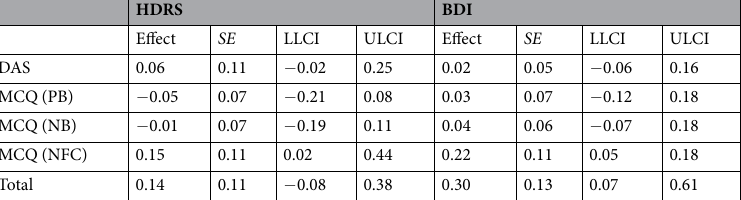
Table 5. Mediation Analysis Part 2: The Indirect Effects of the Potential Four Mediators on Both Outcomes Brought About by the Treatment. Note Treatment = 0 (health training) or 1 (Metacognitive Training for Depression); DAS = Dysfunctional Attitude Scale; MCQ (NB) = Metacognition Questionnaire, Negative Beliefs; MCQ (NFC) = Metacognition Questionnaire, Need for Control; MCQ (PB) = Metacognition Questionnaire, Positive Beliefs. Mediators and outcomes are residuals to capture change, as described in the methods section. All scores based on 1,000 bootstrap samples. CI